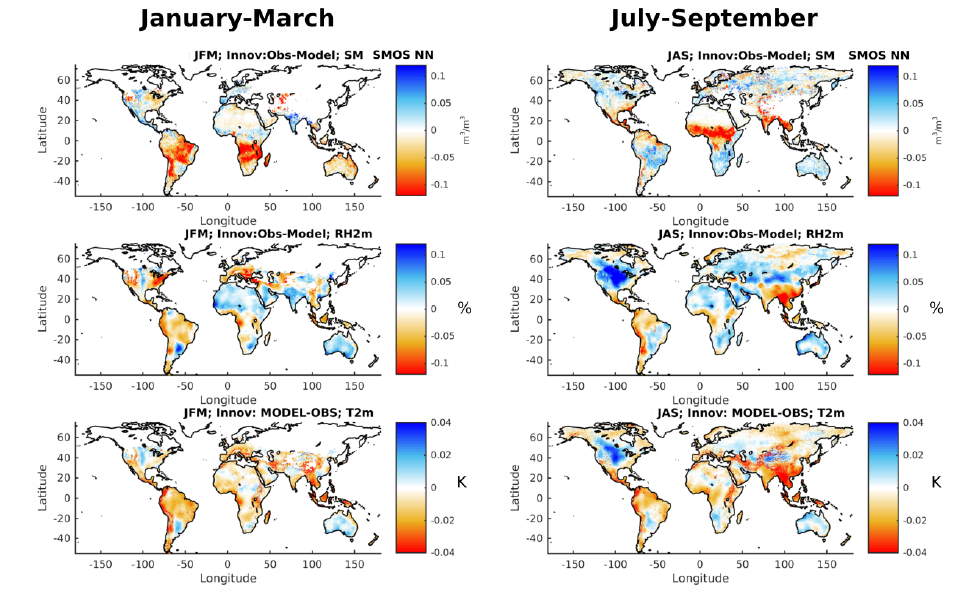
Figure 4. Mean innovations (observation minus model for NNSM and RH 2m and model minus observation for T 2m ) for two periods of three